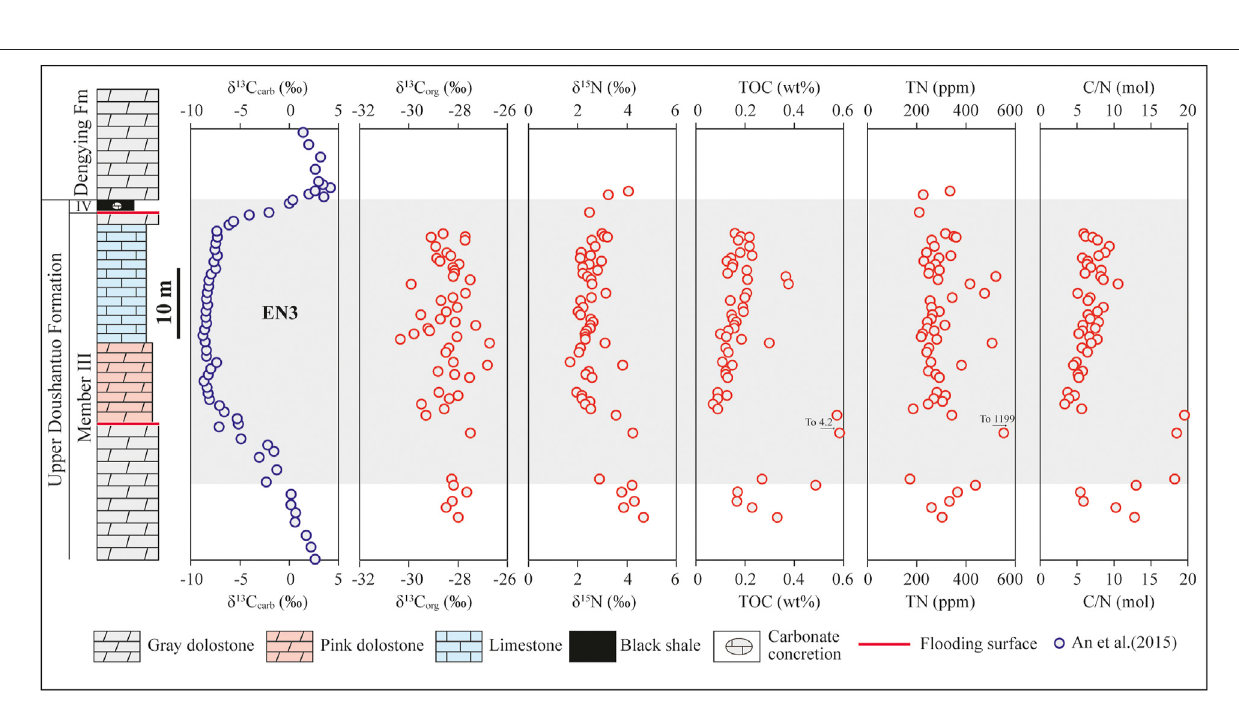
Frontiers in Earth Science |